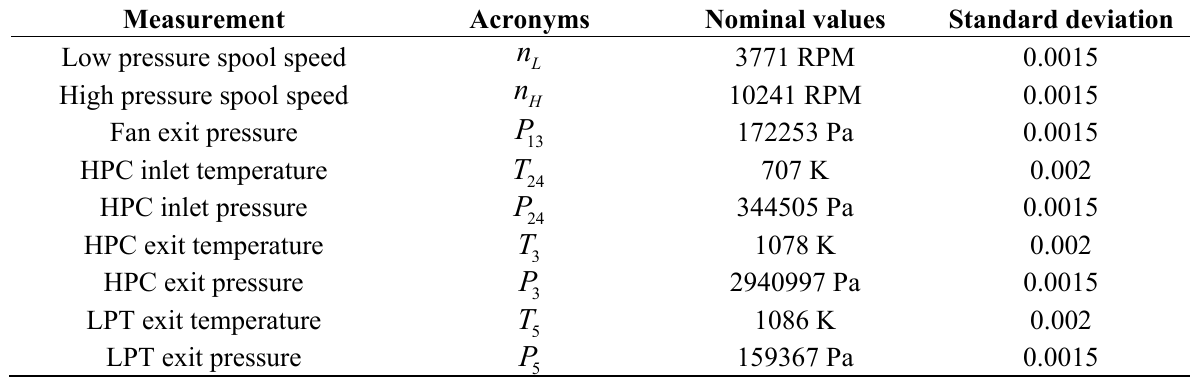
Table 3. CLM turbofan model measurements, nominal values, and standard